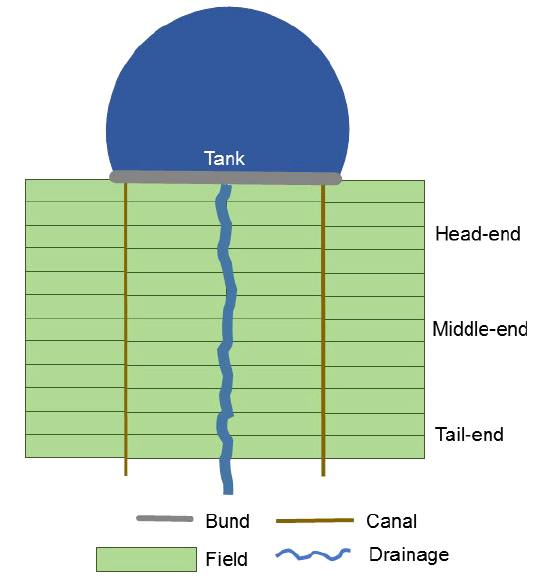
Fig. 1 . Layout of minor village irrigation